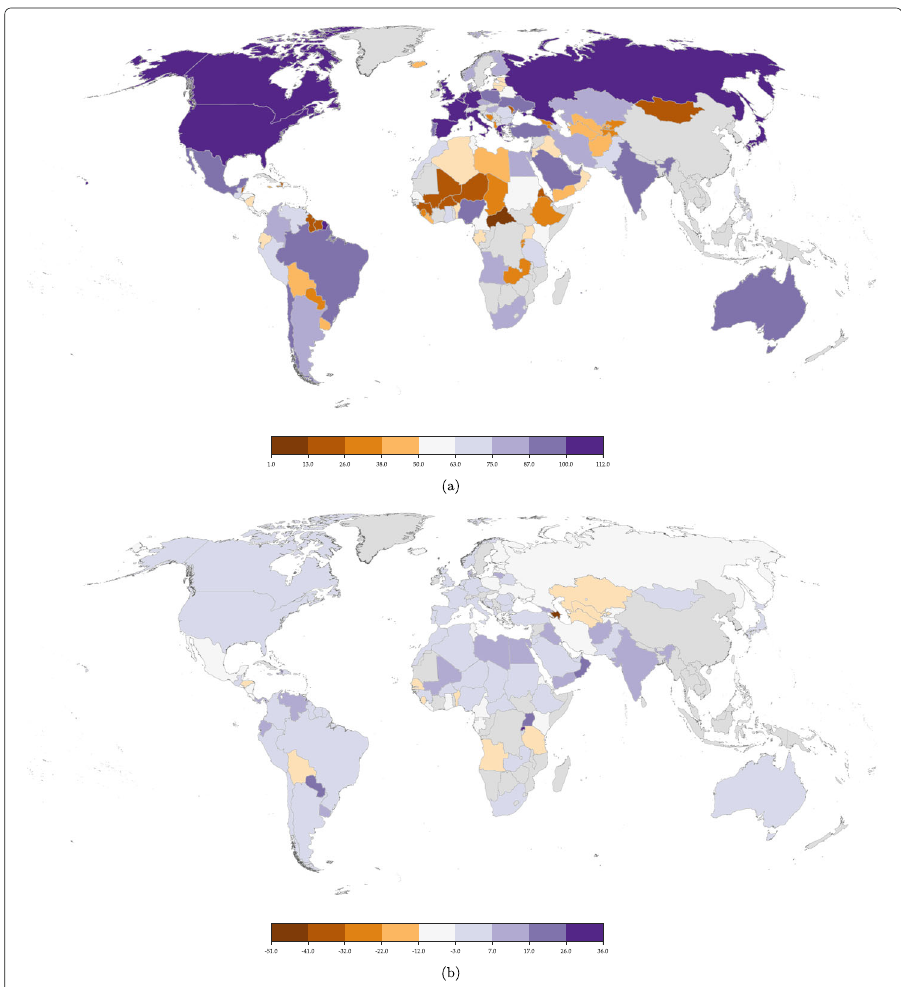
Fig. 21 Geographic distribution of the multiplex hub score (MultiHub). Cross section in 2003 ( a ) and change of the ranking from 2003 to 2010 ( b